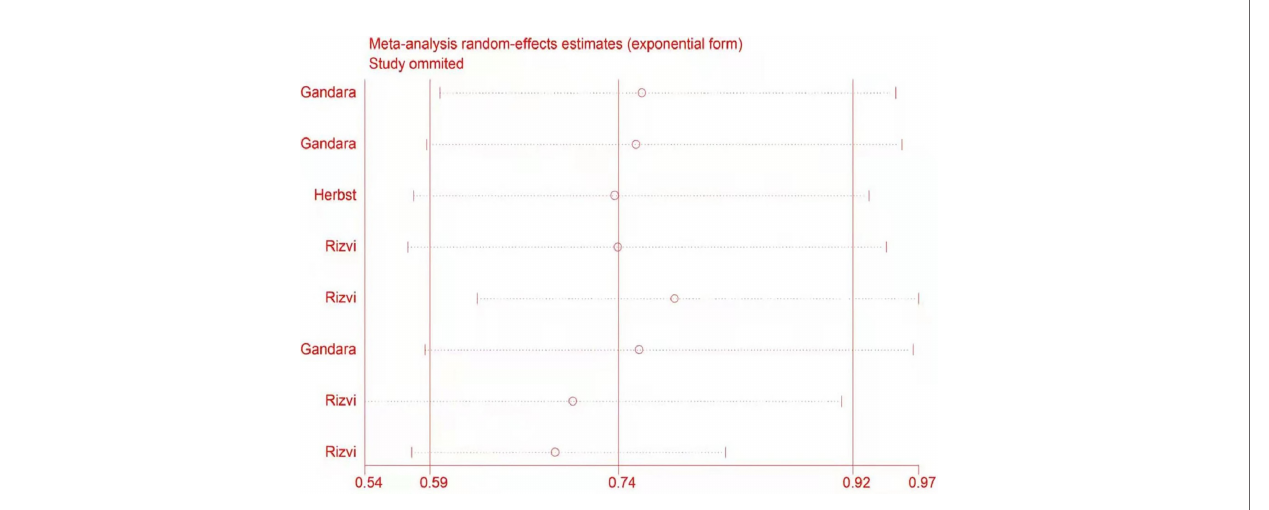
FIGURE 7 | Sensitivity analysis of the potential impact of individual studies on